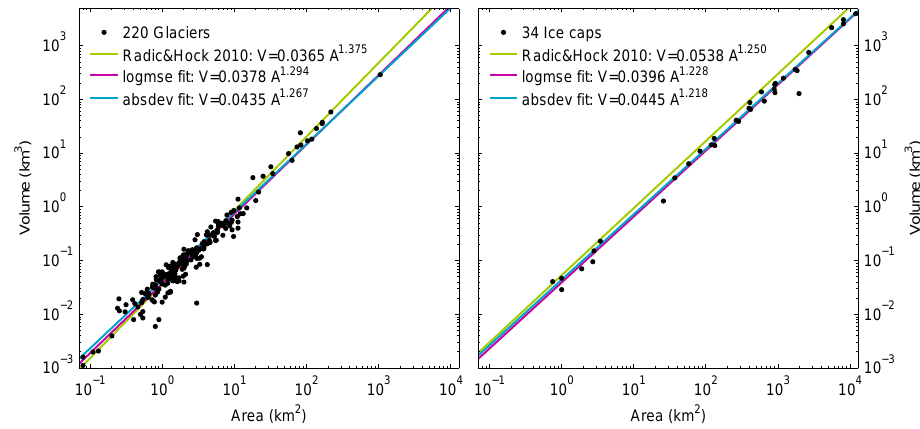
Fig. 2. Area–volume scaling for glaciers (left) and ice caps (right) calibrated to a collection from Cogley (2012). The y-axis is the same so that the smaller volumes for a given area of ice caps can be seen. The fitted lines are from least squares regression of log( V ) and least absolute difference in volume. For comparison, the scaling law used in Radi ´ c and Hock (2010) is also